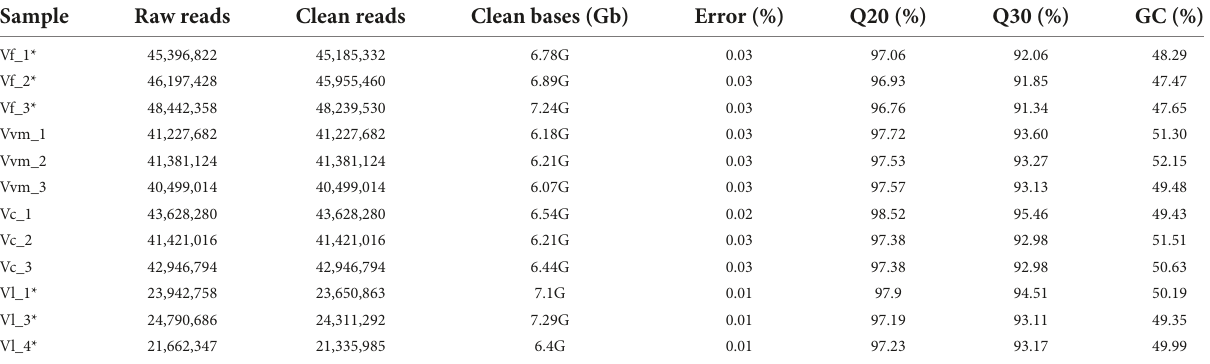
TABLE 1 The summary of sequencing results.